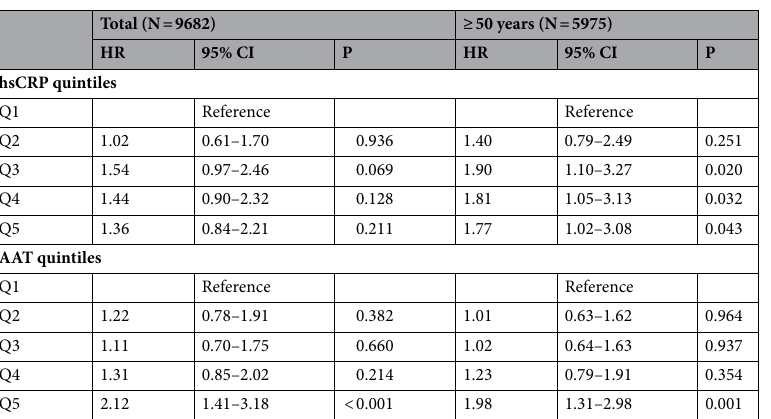
Table 4. Cox proportional hazard analysis for all-cause mortality. Adjusted factors were age, sex, body mass index, current smoking, heavy drinking, history of cancer, history of cardiovascular disease, mean blood pressure, hemoglobin A1c, high-density lipoprotein cholesterol, low-density lipoprotein cholesterol, creatinine, alanine aminotransferase, and gamma-glutamyltransferase. The quintiles of high-sensitivity CRP (hsCRP) and α1-antitrypsin (AAT) levels were calculated for all participants. All independent variables showed P -values greater than 0.05 using the Schoenfeld residuals test.